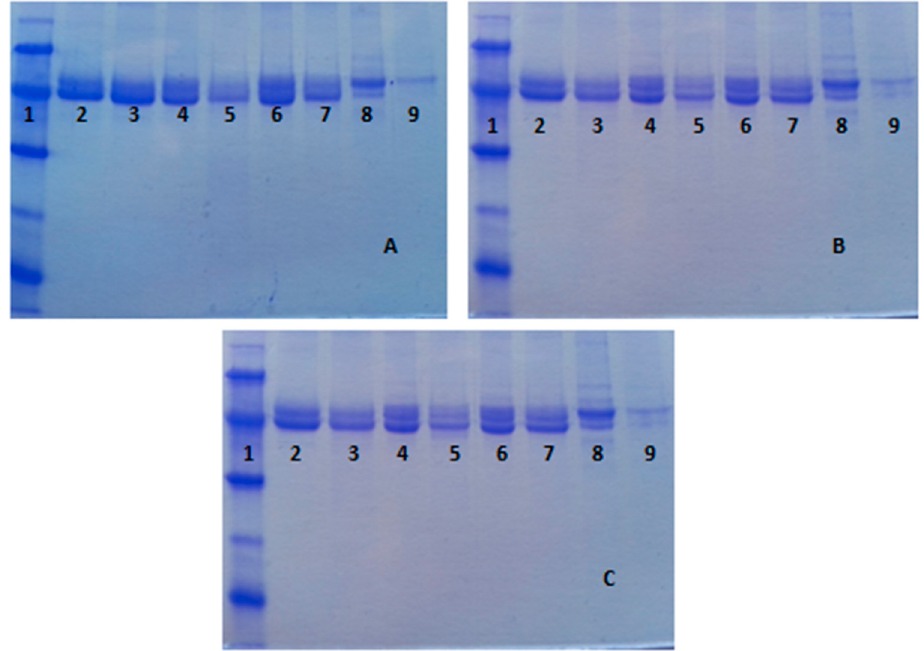
Figure 5. SDS-PAGE analysis of different CALA preparations after thermal inactivation at different pH values. Experiments have been performed as described in Section 2. ( A ) pH 5, (inactivated at 80 ˝ C); ( B ) pH7 (inactivated at 80 ˝ C) and ( C ) pH 9 (inactivated at 70 ˝ C). Other specifications are described in Section 2 or in the Table 1. Lane 1: Low Molecular Weight Marker, Lane 2: OC, Lane 3: OC incubated at pH 5, Lane 4: OCEDA, Lane 5: OCEDA incubated at pH 5, Lane 6: OCHDA, Lane 7: OCHDA incubated at pH 5, Lane 8: EDA and Lane 9: EDA incubated at pH 5.